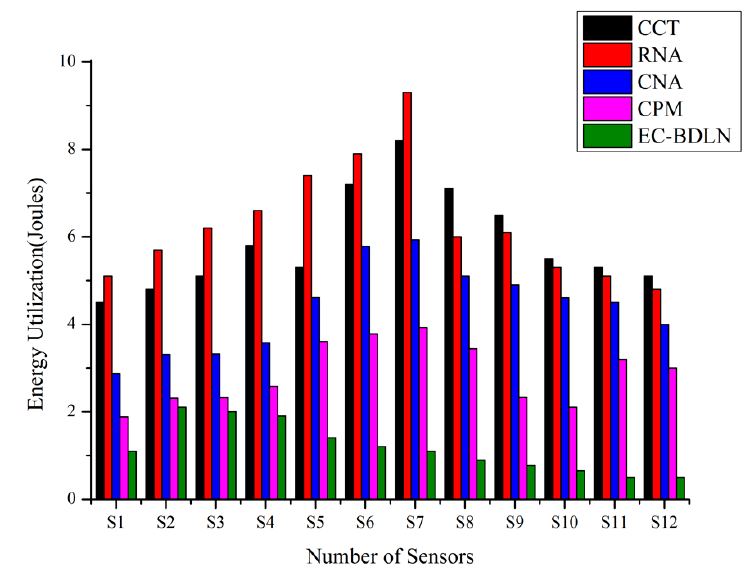
Figure 10. Energy utilization factor of EC-BDLN.